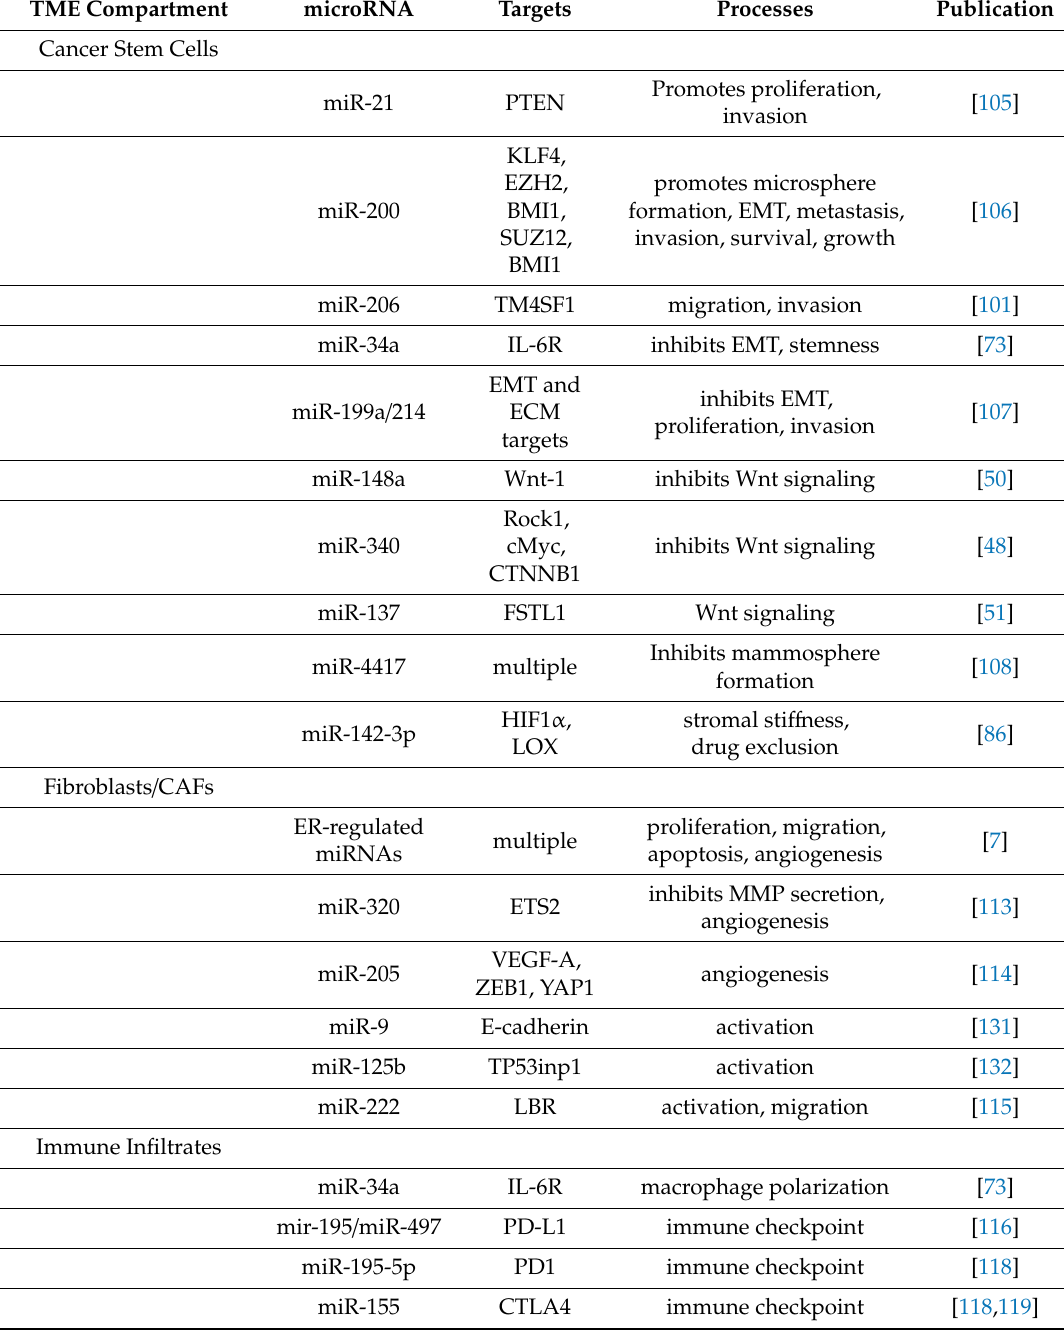
Table 1. Select miRNAs in the TNBC